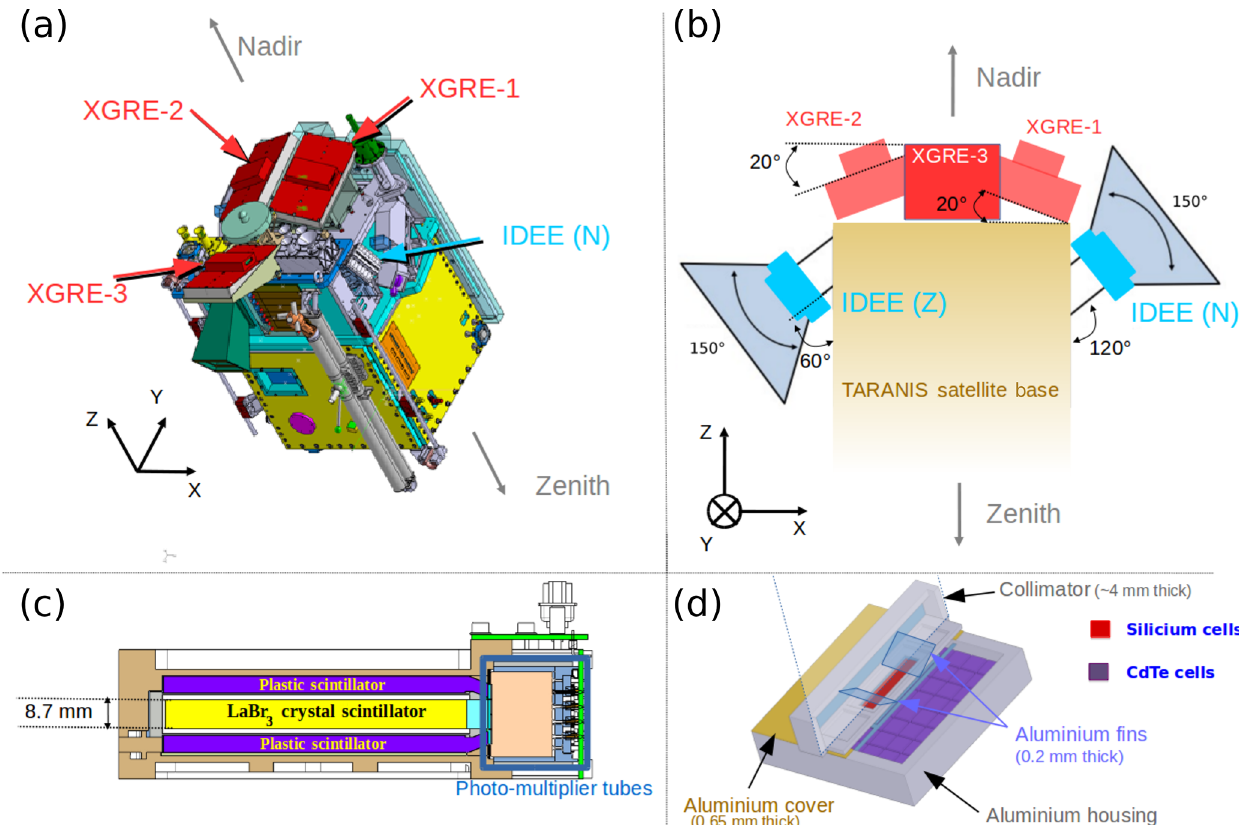
Figure 1. (a) 3-D view of the TARANIS spacecraft. The position of the three XGRE sensors are indicated, as well as one of the two IDEE detectors (the other is hidden). (b) Schematic side views of the TARANIS spacecraft. The three XGRE sensors are highlighted in red and the two IDEE detectors are highlighted in cyan. The relative positioning and orientation of the instruments are accurately represented. For more clarity, the relative scale of the two IDEE detectors is slightly bigger than in reality. (c) Cross-section view of a XGRE detector unit, highlighting the sandwich design of plastic / LaBr 3 scintillators. (d) Partial cross-section view of one IDEE detector’s head. The position of the sensitive cells used to detect electrons (silicon and CdTe) are